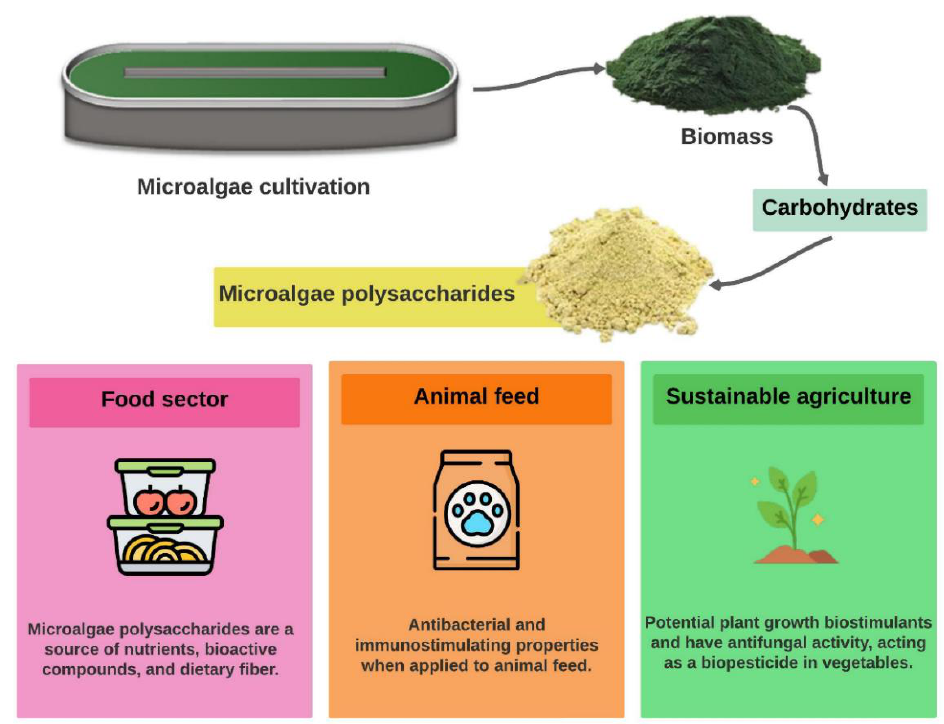
Figure 2. Advantages of using microalgae polysaccharides in the food, animal feed, and sustainable agriculture sectors. Table 3. Applications of microalgae polysaccharides in the food, animal feed and agriculture sector.